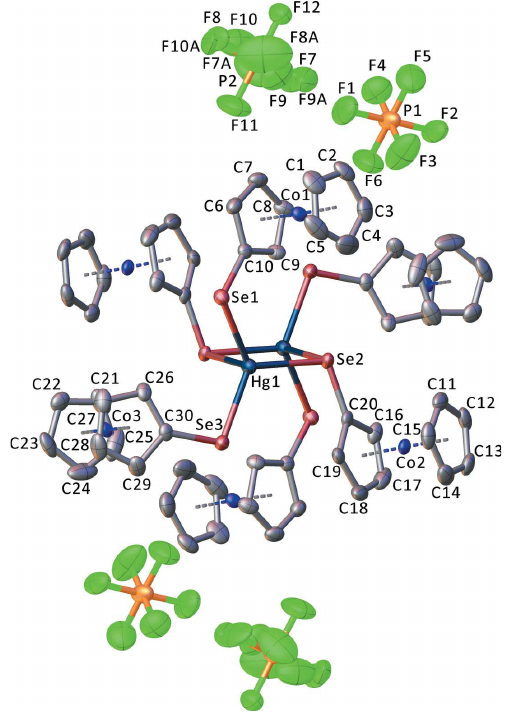
Figure 1 The molecular entities of the title salt, with displacement ellipsoids drawn at the 50% probability level. Hydrogen atoms and solvent molecules were omitted for clarity. Non-labeled atoms are generated by symmetry operation (cid:3) x + 1, (cid:3) y + 1, (cid:3) z + bond lengths are 2.5476 (3) (Se1—Hg1) and 2.5451 (3) A˚ (Se3—Hg1), whereas the bridging Se2—Hg1 bond lengths